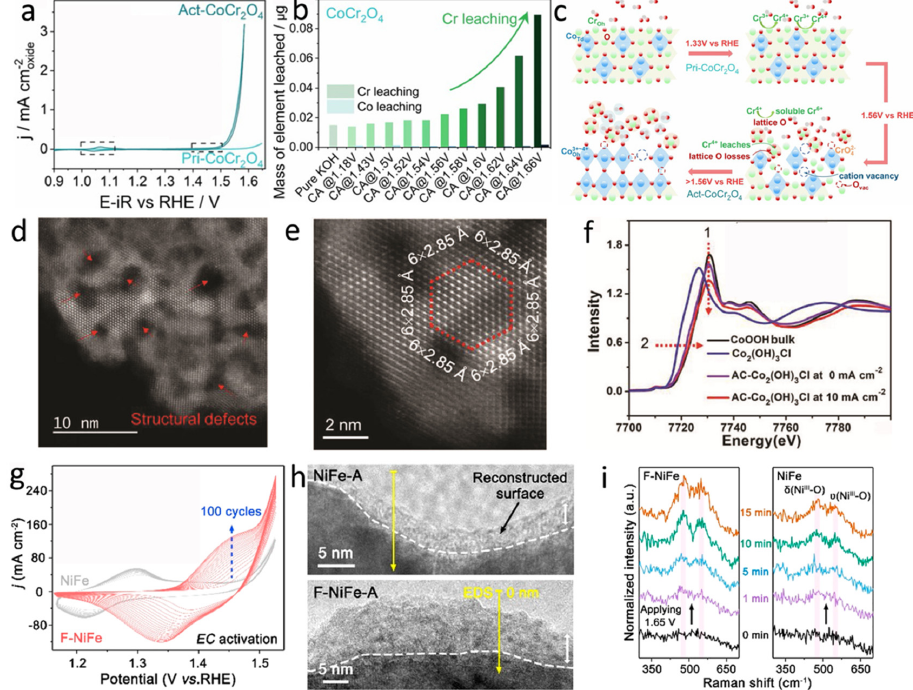
Figure 5. ( a ) CV curves of CoCr 2 O 4 with the initial state (2nd cycle) and after chronoamperometry (at 1.7 V for 1.5 h). ( b ) The cumulative mass of Co and Cr leached after consecutive series of chronoamperometry conducted at 20mins interval for CoCr 2 O 4 . ( c ) Scheme of CoCr 2 O 4 surface reconstruction before OER testing after being applied increased potentials. Reproduced with permission [113]. Copyright 2021, Wiley-VCH. ( d ) STEM and ( e ) atomic-resolution HAADF-STEM images of the AC-Co 2 (OH) 3 Cl. ( f ) Normalized Co K-edge XANES spectra of the Co 2 (OH) 3 Cl, AC-Co 2 (OH) 3 Cl under OER and non-OER conditions as well as the reference (CoOOH bulk). Reproduced with permission [66]. Copyright 2019, Wiley-VCH. ( g ) CV curves of the F-NiFe and NiFe in an alkaline solution. ( h ) HRTEM images of F-NiFe-A and the NiFe-A. ( i ) Operando Raman spectra of F-NiFe and the NiFe. Reproduced with permission [114]. Copyright 2021, American Chemical